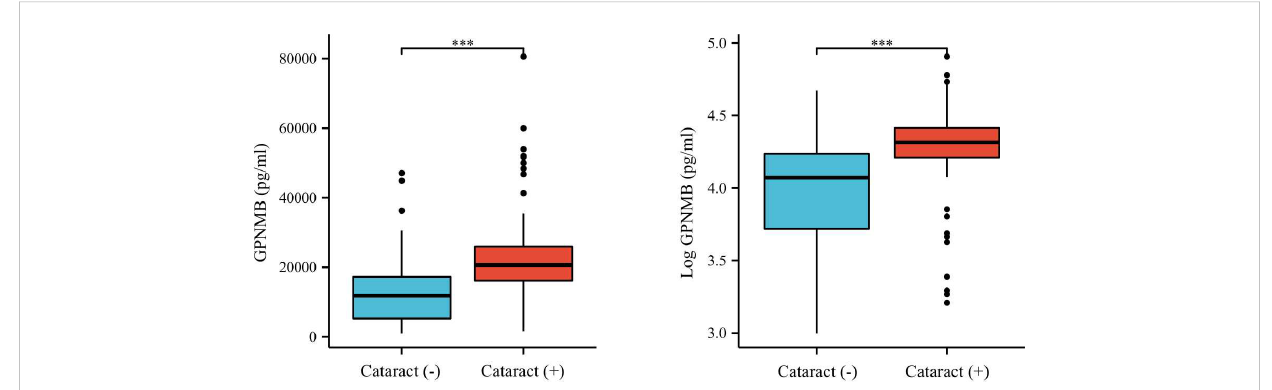
FIGURE 3 Plasma GPNMB levels depending on the existence of cataract. ***P < 0.001 using a Wilcoxon rank sum